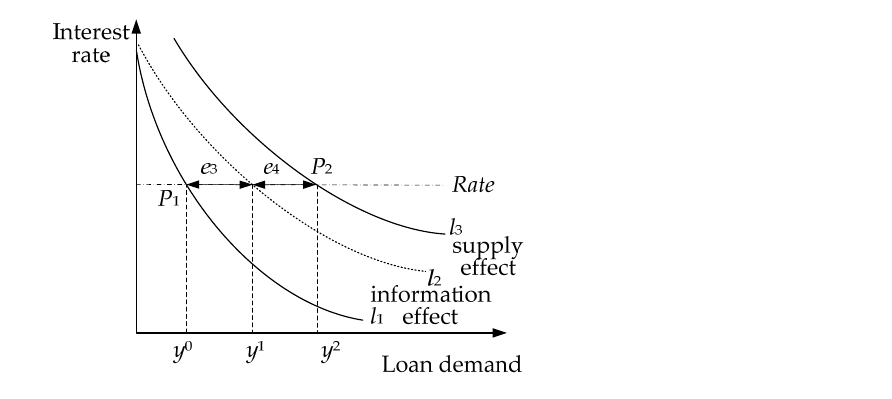
Figure 2. Mechanism of the impact of digital payment on the bank loans of farmer households.